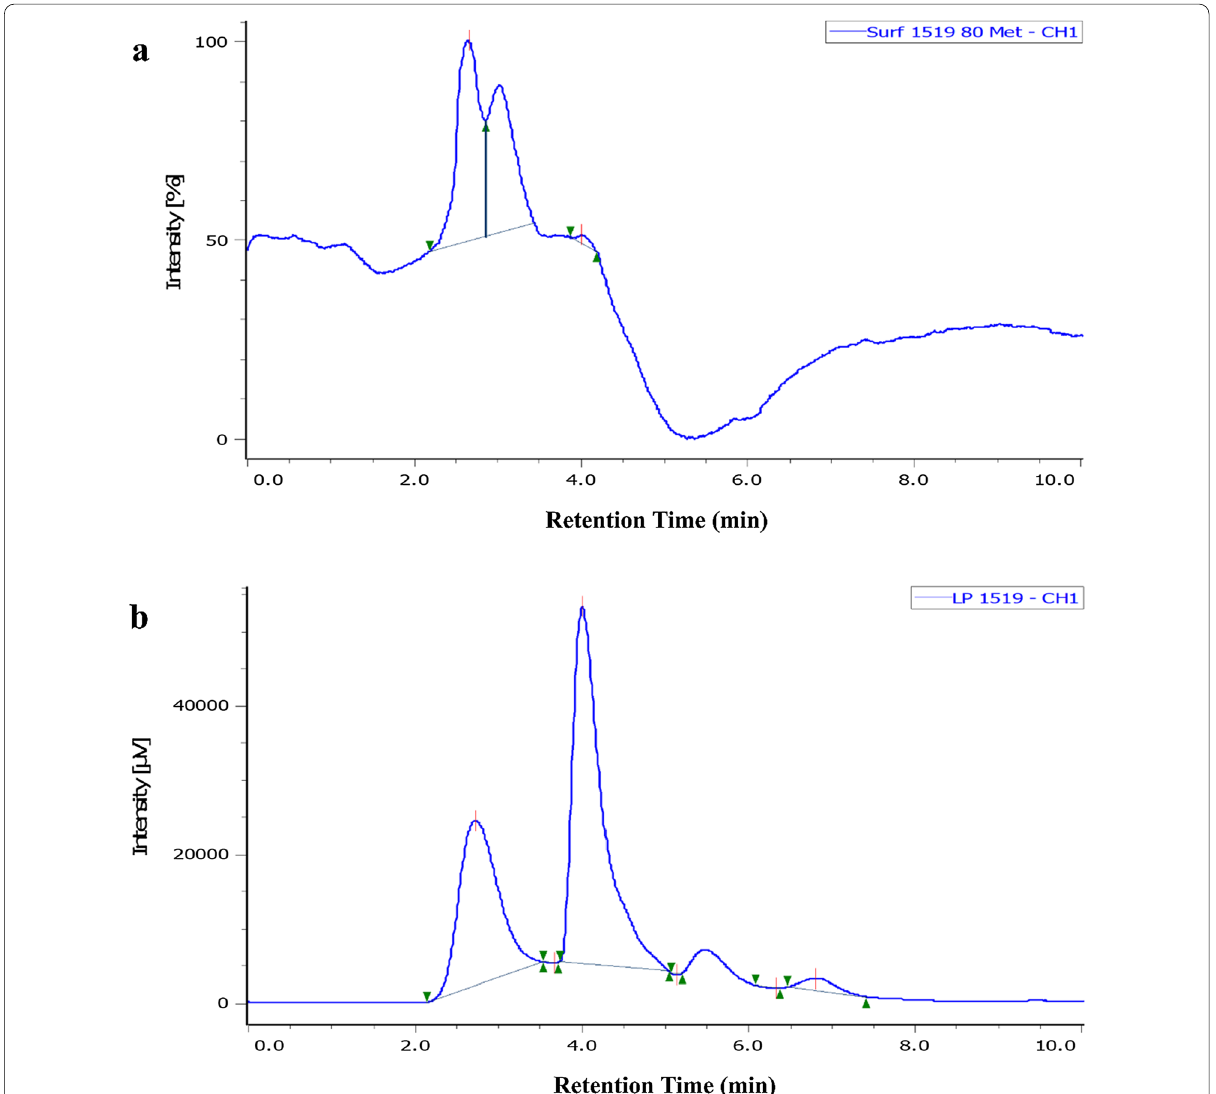
Fig. 4 Reverse-phase HPLC purification of lipopeptides produced by B. velezensis SK Chromatogram of a Standard surfactin, b Chloroform extracted lipopeptides using mobile phase 80% methanol in water over 30